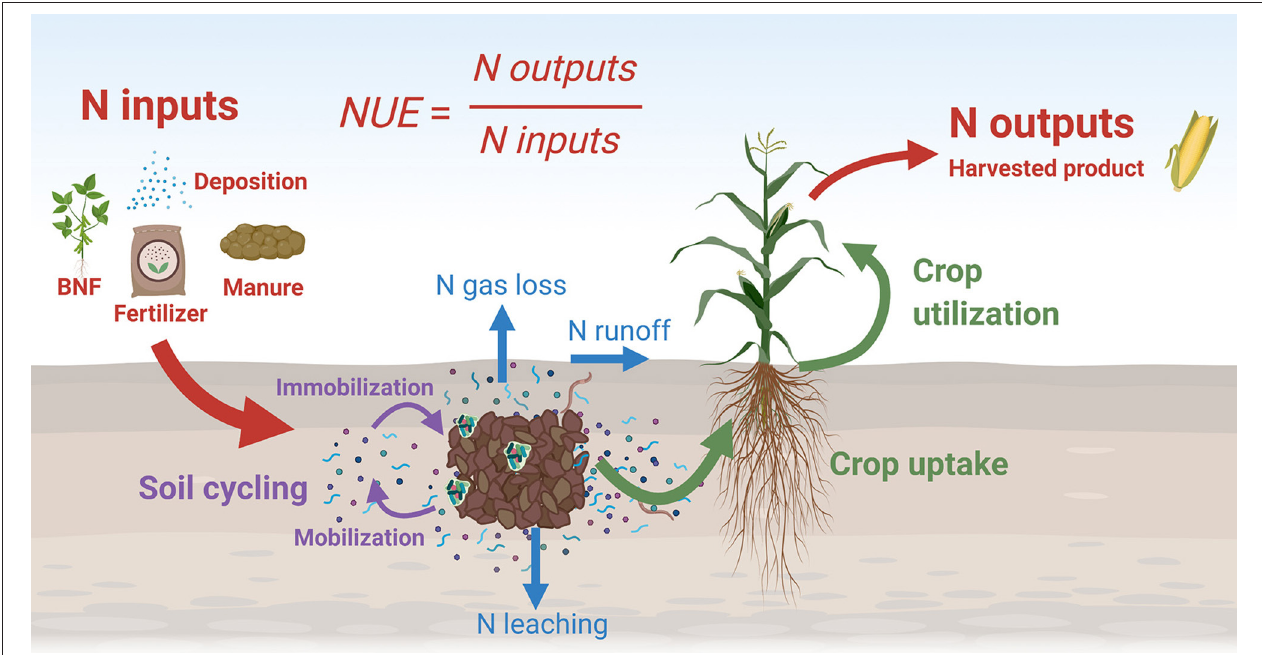
FIGURE 1 | Nitrogen use efficiency (NUE) is the ratio of N outputs in the harvested product to N inputs, including from fertilizer and natural processes, and has also been called N removal efficiency. Nitrogen inputs to the system (red arrow, BNF is biological nitrogen fixation) will cycle through the soil (purple arrows), are susceptible to environmental losses (blue arrows), and are eventually used by crops (green arrows) with a portion harvested or removed (red arrow). We propose simultaneously targeting these different processes to increase NUE and agricultural